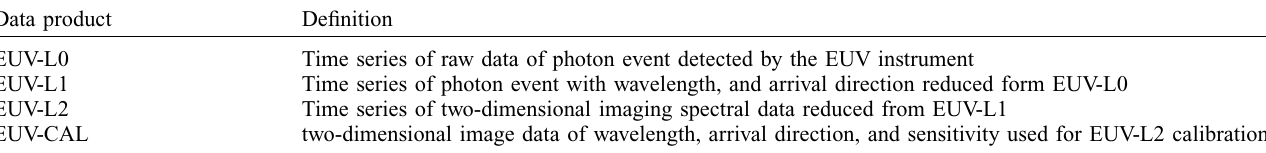
Table 1. Product list for EUV instrument data.